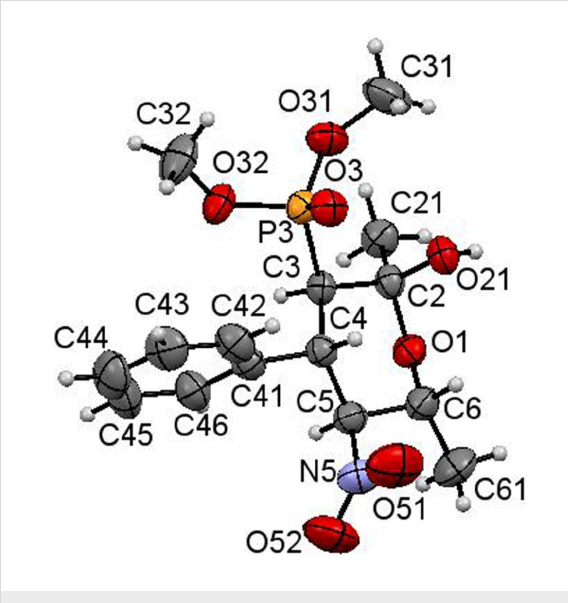
Figure 4: ORTEP diagram of (2 S ,3 R ,4 S ,5 S ,6 R )- 13b .